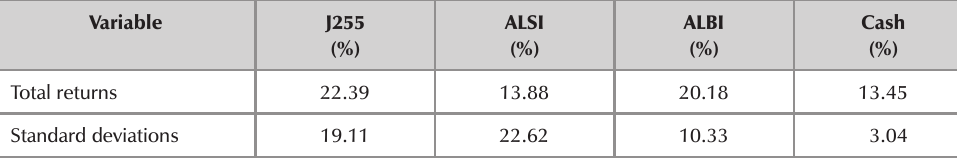
Averaged returns of, correlation co-efficients and covariances between indices: